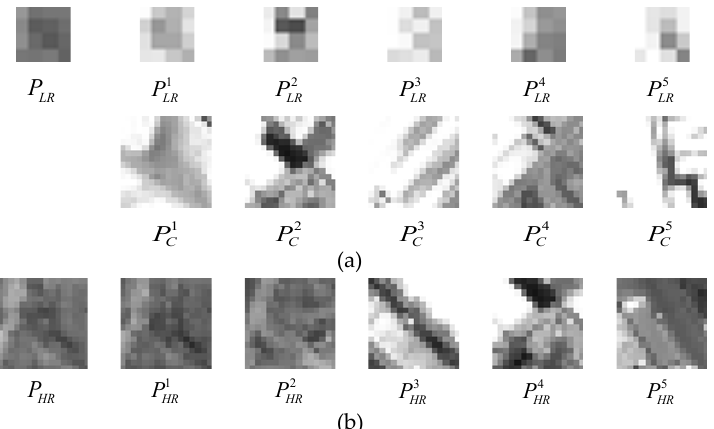
Figure 1. Mismatch of coding pattern in HR/LR spaces. Because the mismatch of manifolds between HR/LR patches, the neighbors found for LR patches cannot be consistent with the neighbors for HR patches.